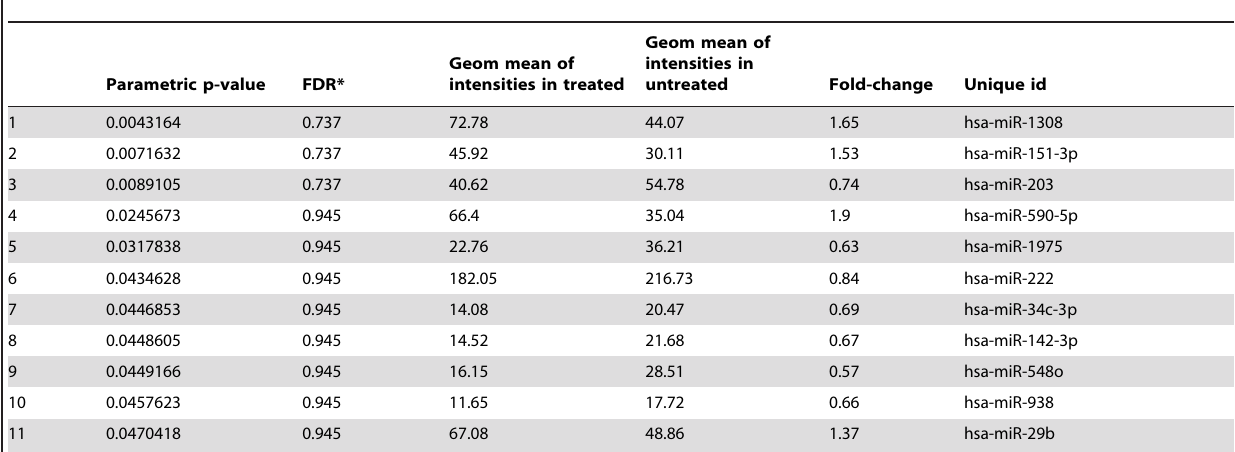
Table 2. MicroRNA expression changes with exposure to HAG (260 m g/ml): Fold Change Analysis (Untreated Vs Treated).